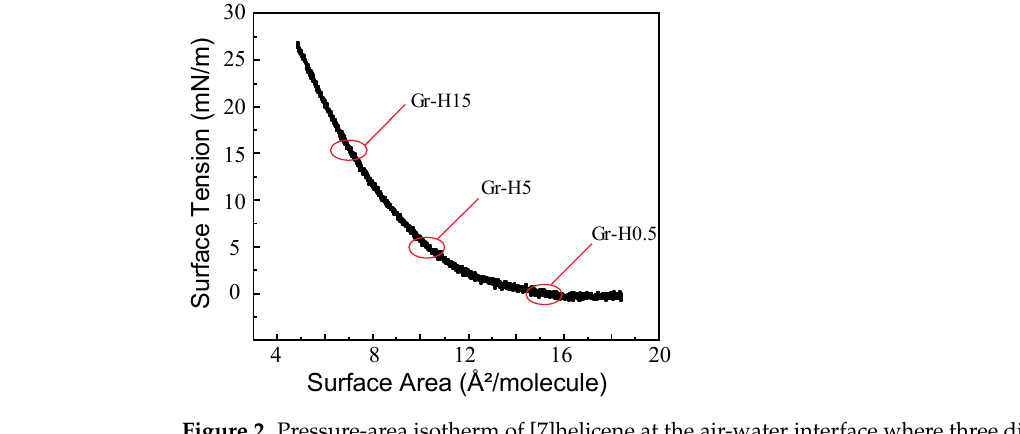
Figure 2. Pressure-area isotherm of [7]helicene at the air-water interface where three different surface pressures were used to prepare helicene films on graphene (GR-H15, GR-H5, and GR-H0.5). The amplitude error is an extremely sensitive mode of AFM for determining the shape of the topographical features of surfaces involving different phases. Figure 3a–d shows the amplitude error signal of bare GR and helicene coated GR at a surface pressure of 0.5 mN/m, 5 mN/m, and 15 mN/m. While the GR sample was relatively smooth as a whole, a few wrinkles could be observed. As the lateral compression pressure increased, the inter-domain distance of helicene self-assemblies decreased. At the surface pressure of 15 mN/m, the GR substrate was fully covered with helicene domains and more well- defined shape (hexagonal) domains were observed indicating an entropically-induced crystallization process. The amplitude error and the height sensor image can be found in supporting information Figure S1, which shows the uniformly covered surface with the condensed phase of the deposited helicene on the Gr-H15, Gr-H5, and Gr-H0.5 have a similar conclusion.